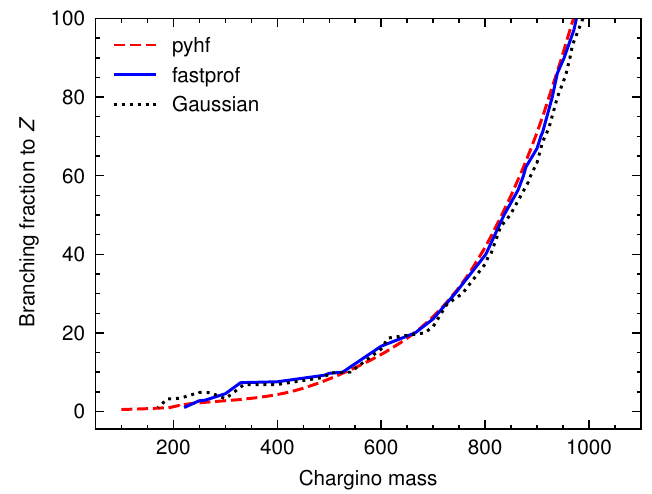
Figure 5 . Exclusion plot in the plane of chargino mass and its branching ratio to Z bosons, assuming equal branching ratios to W and H and to all lepton flavors. The computation from SLLS simplified likelihoods (solid blue) is compared with a reference (dashed red) taken from the top-left panel of figure 9 in ref. [17] and good agreement is observed. Gaussian models computed from the full likelihood as described in the text (dotted black) also show good agreement in this